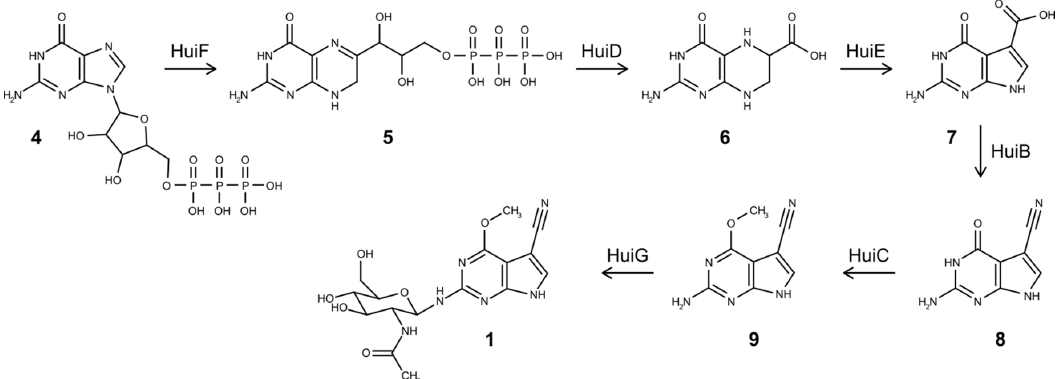
Figure 4. Proposed biosynthetic pathway of huimycin. ( 4 ) GTP, ( 5 ) 7,8-dihydroneopterin triphosphate, ( 6 ) 6-carboxy-5,6,7,8-tetrahydropterin, ( 7 ) 7-carboxy-7-deazaguanine, ( 8 ) 7-cyano-7-deazaguanine, ( 9 ) 2-amino-6-methoxy-7-cyano-7-deazapurine, and ( 1 ) huimycin.